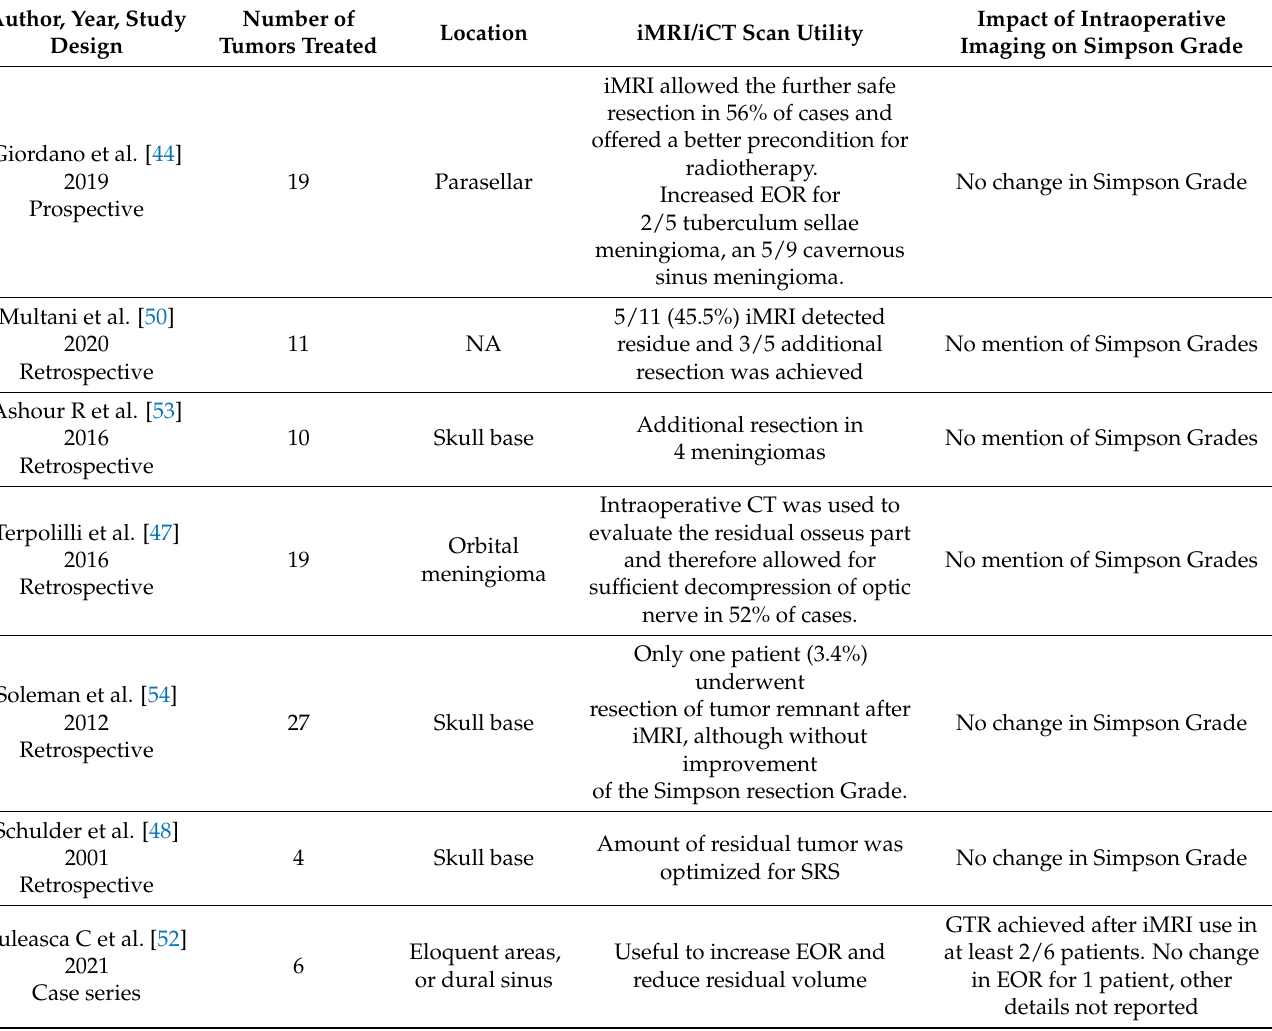
Table 3. Summary of studies reporting utility of intraoperative imaging to enhance extent of resection for